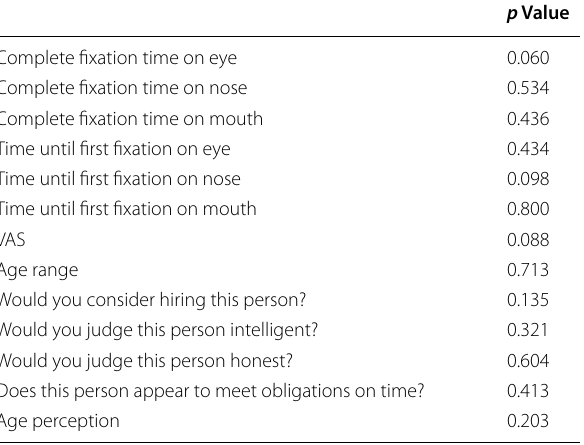
Table 5 Comparing sex with